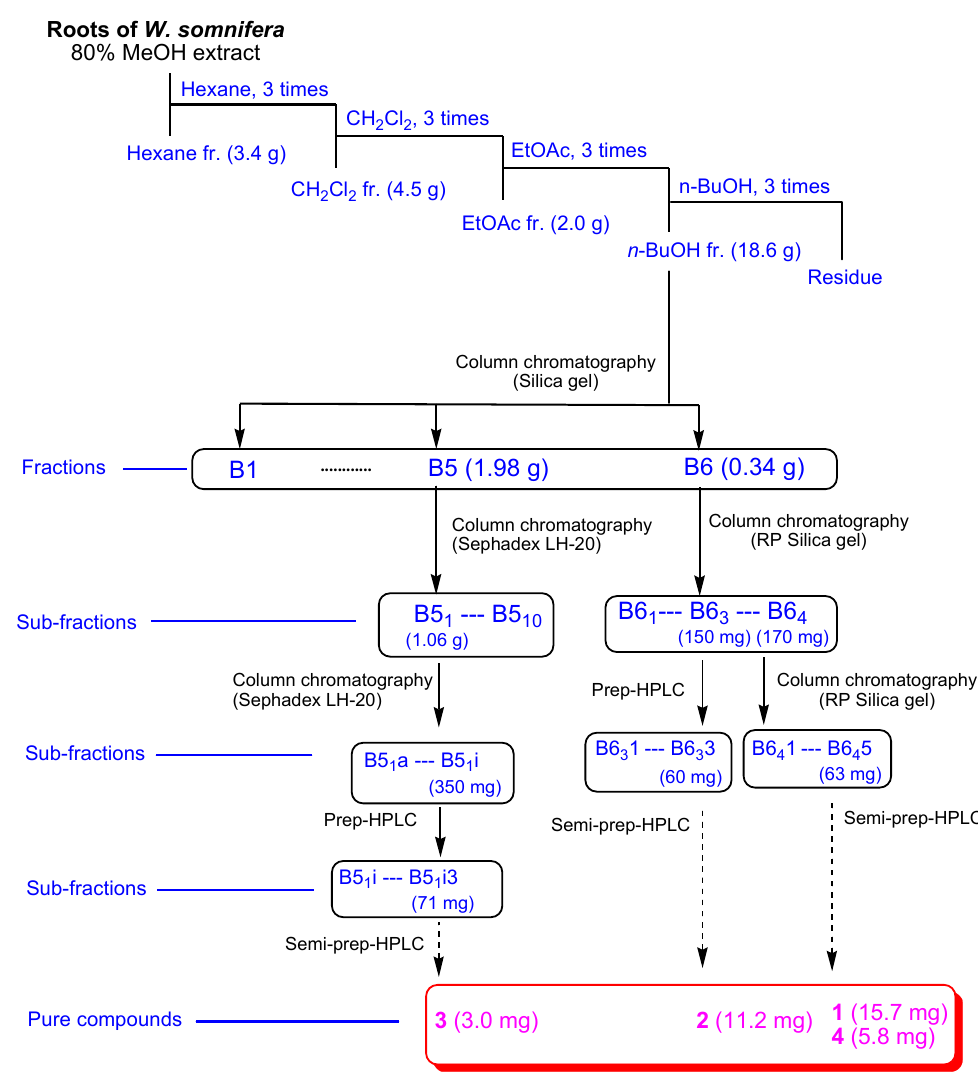
Figure 1. The separation scheme of compounds 1 – 4 .